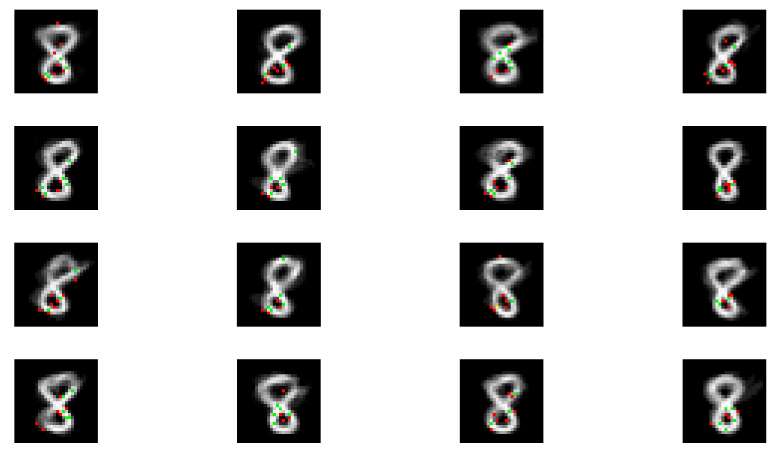
Figure 7. Centroids of 16 rules with their antecedents generated from R 168 in the fully connected